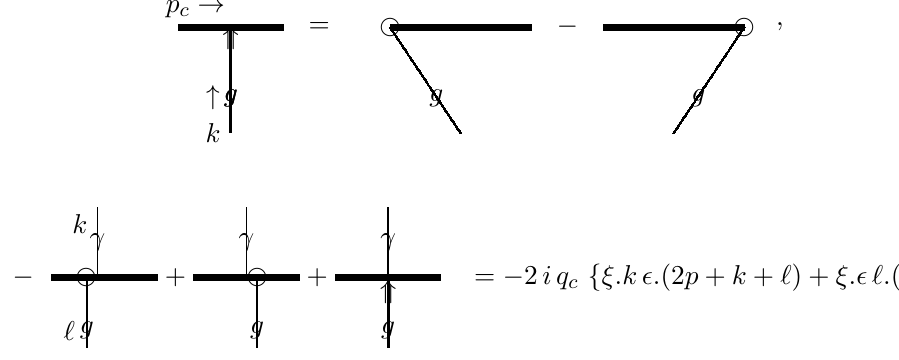
Figure 21 . Analog of (cid:12)gure 4 for graviton in the presence of a photon. The graviton carries a polarization ( (cid:24) (cid:22) ‘ (cid:23) + (cid:24) (cid:23) ‘ (cid:22) ) and the photon carries a polarization (cid:15) . The circled vertex has been explained in the caption of (cid:12)gure